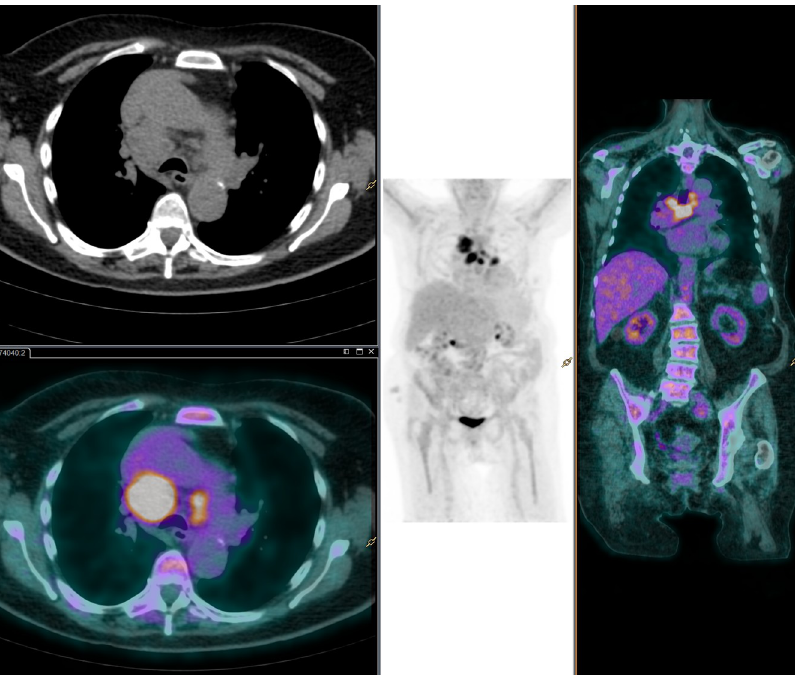
Fig 3. 18 FDG-PET/CT images. A 89-year-old woman 18F-FDG PET/CT with diagnostic of polimyalgia rheumatica. PET/CT images showed multiple mediastinal nodules with increase 18 F-FDG uptake and bone marrow glucose hypermetabolism. The patient was finally diagnosed of in a lymphoproliferative process. No treatment was administered due to age and other concomitant pathologies.